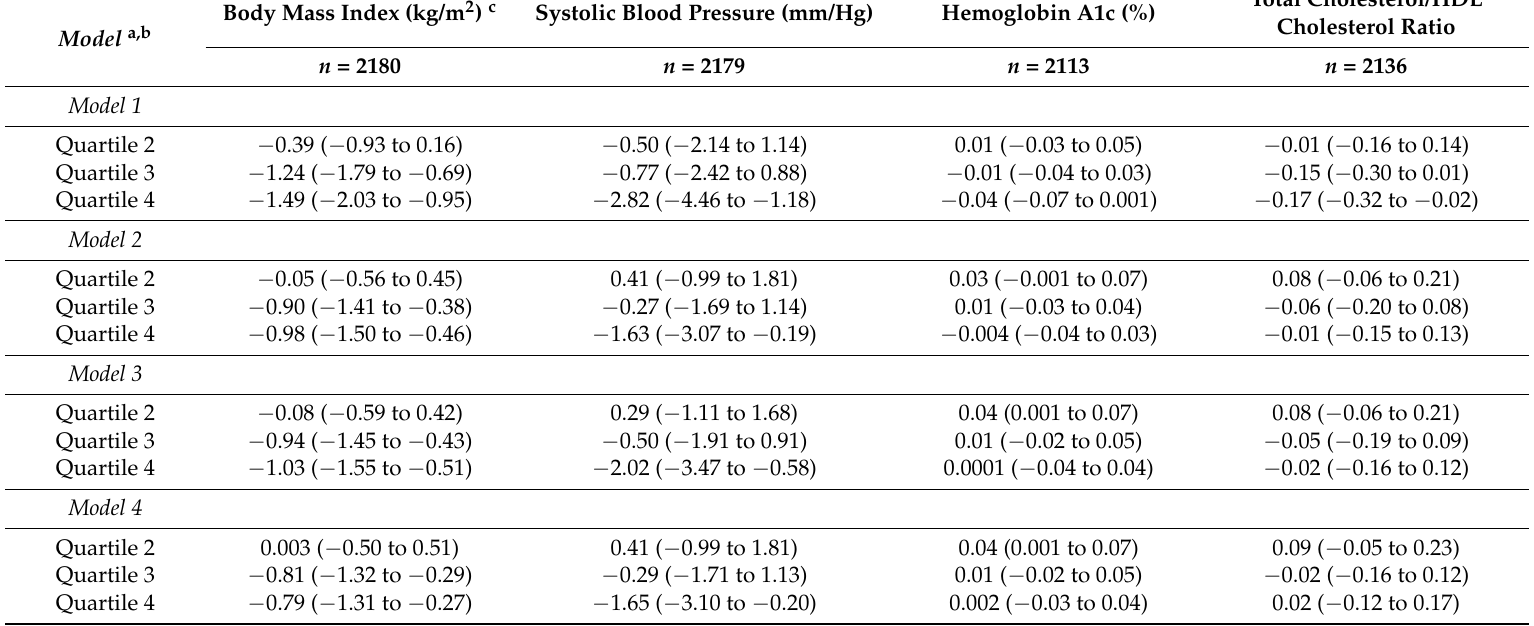
Table 2. Mean differences in the markers of cardiometabolic health across quartiles of an index of neighborhood active-living friendliness (95% confidence intervals). Participants from the Canadian Health Measures Survey